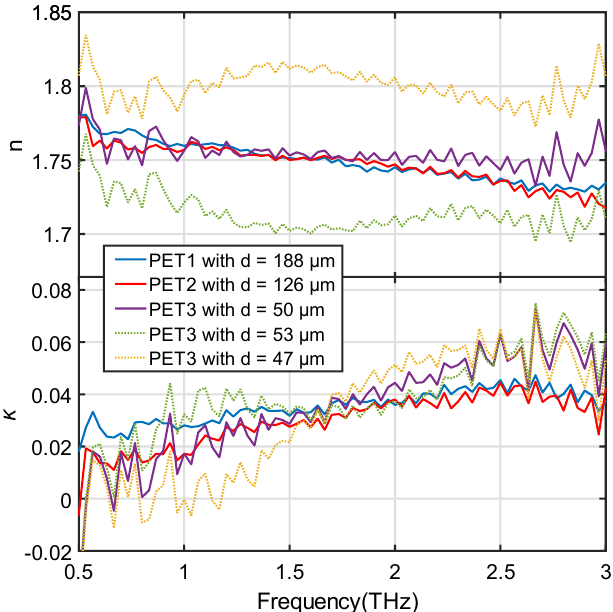
Figure 3. n and κ of the 188 μm (PET1), 125 μm (PET2), and 50 μm (PET3) PET films at their optimized thicknesses (solid curves), compared to the n and κ of PET3 characterized by using the optimized thickness with a ±3 μm error.